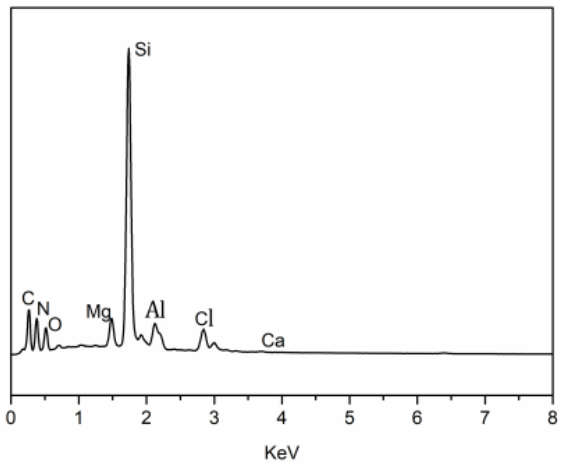
Figure 7. EDS spectrum of the black area on the worn surface of the SN20 pin against the PEEK disc at the speed of 1.73 m/s.